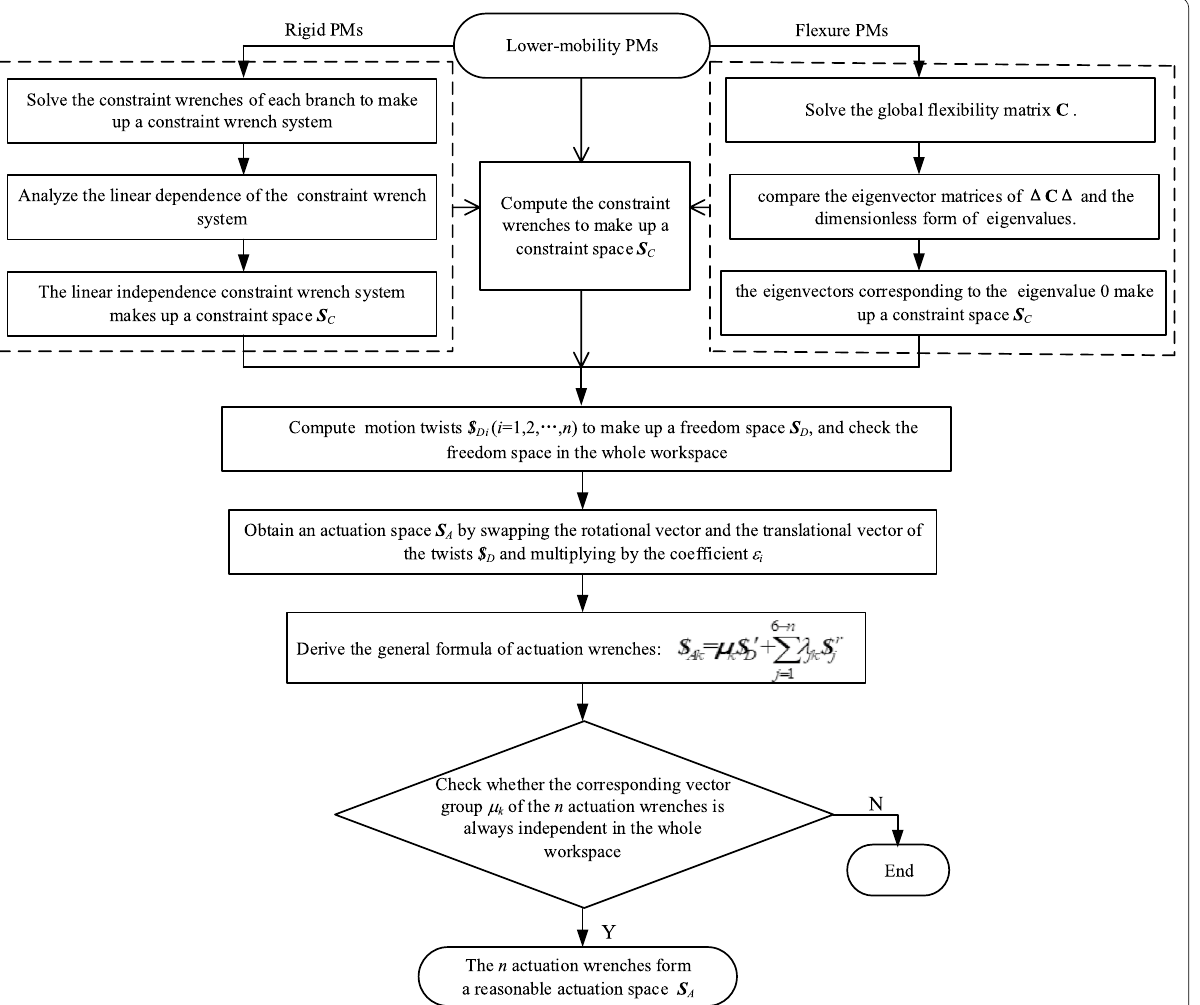
Fig. 1 Flow chart of synthesizing the actuation spaces of both rigid and flexure parallel